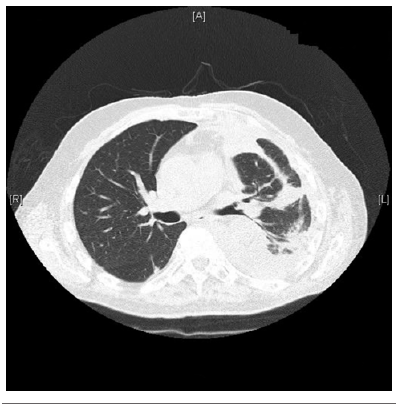
Figure 4. Repeat chest radiography taken seven days after starting treatment showed resolving pleural disease.